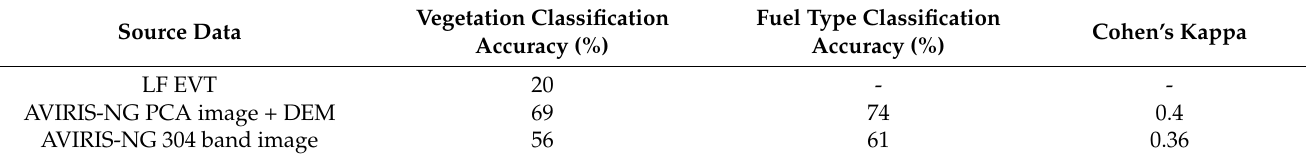
Table 4. Classification accuracy for vegetation and fuel type classification from different source data at CPCWR. “-“ indicates data wasn’t available for